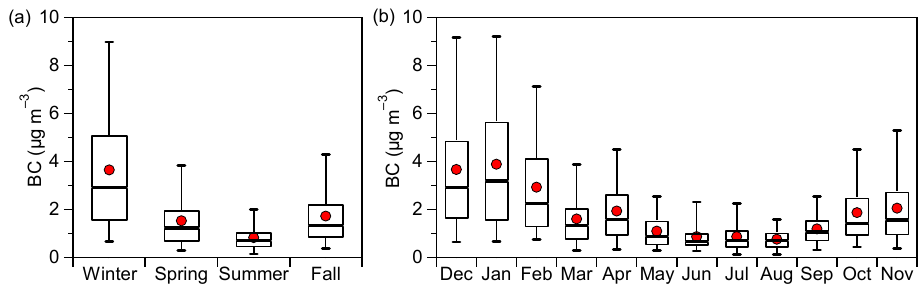
Figure 3. Box plots for the BC mass concentration in different seasons ( a ) and month ( b ). In each symbol, the whiskers above and below box mark the 90% and 10% percentiles, respectively; the upper and lower edge of the boxes represent the 75% and 25% percentiles, respectively; and the lines and circles inside the boxes denote median and mean values, respectively.